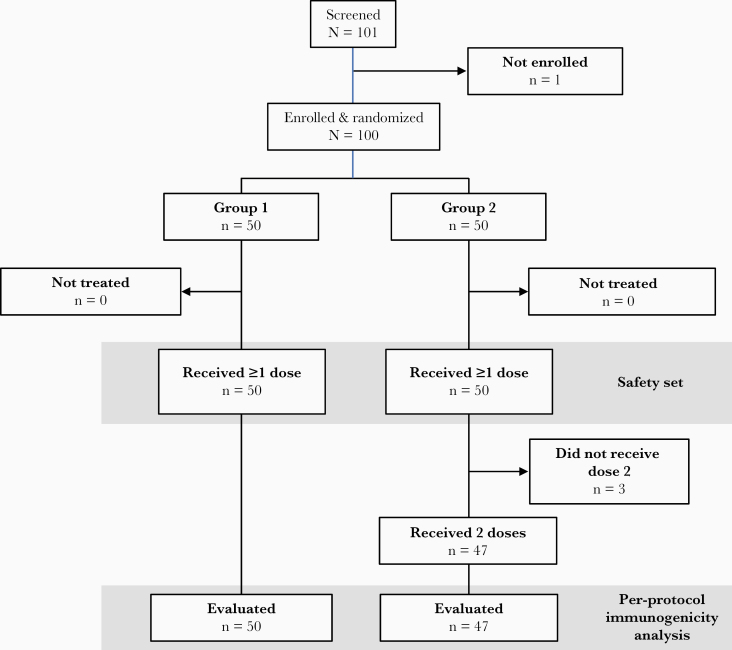
Flow chart of the study.